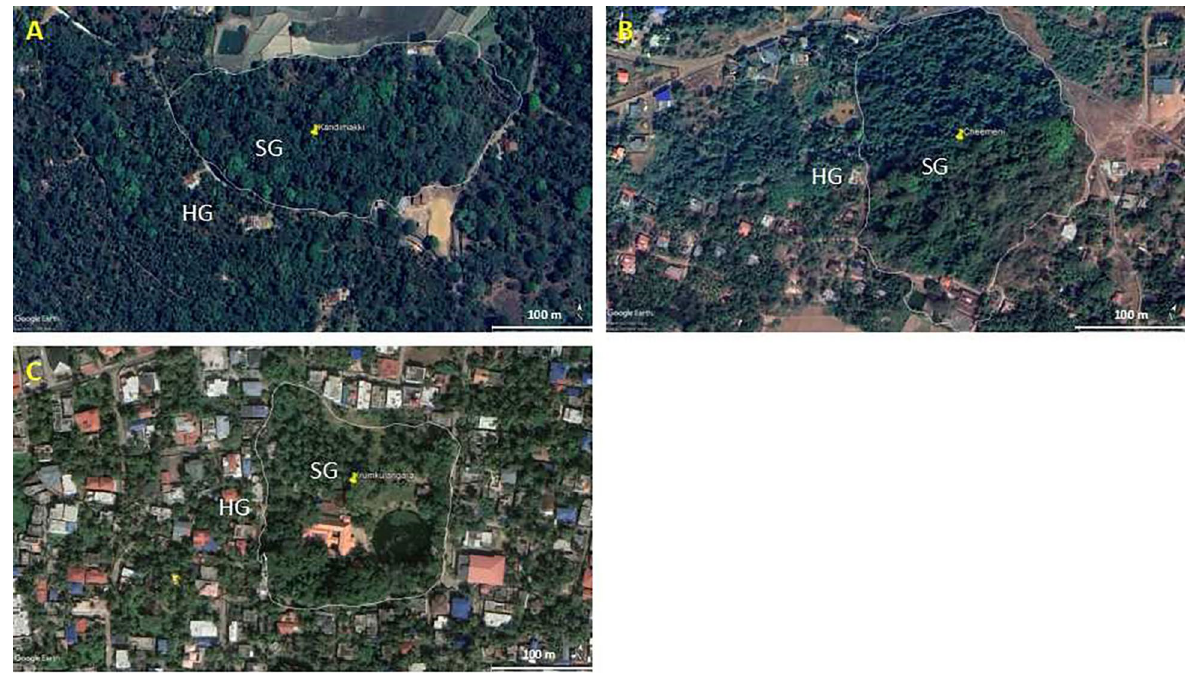
Figure 1. Google earth images of the representative sampling sites in ( A ) less-, ( B ) moderate-, and ( C ) highly- urbanized landscape in Coorg, Kasaragod, and Trivandrum. Copyright: GOOGLE EARTH